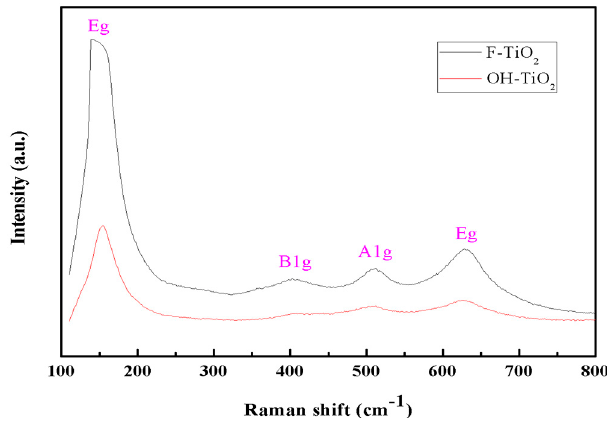
Figure 3. Raman spectroscopy of catalysts.